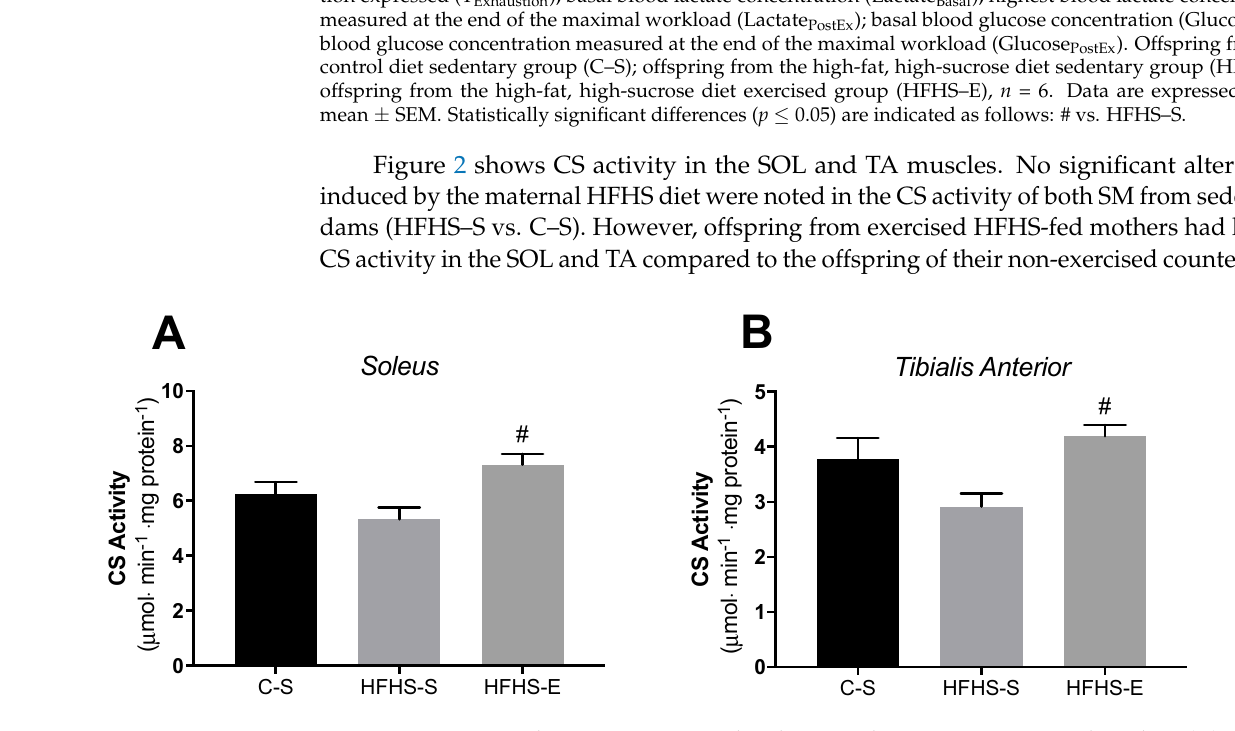
Figure 2. Citrate synthase activity normalized to muscle protein content in the soleus ( A ) and the tibialis anterior ( B ). Offspring from the control diet sedentary group (C–S); offspring from the high-fat, high-sucrose diet sedentary group (HFHS–S); offspring from the high-fat, high-sucrose diet exercised group (HFHS–E), n = 6. Data are expressed as the mean ± SEM. Statistically significant differences ( p ≤ 0.05) are indicated as follows: # vs. HFHS–S. The coefficient of variation in the soleus was: 6.8% for the C–S group; 4.5% for the HFHS–S group; and 4.3% in the HFHS–E group. In the tibialis anterior the coefficient of variation was: 5.7% for the C–S group; 7.1% for the HFHS–S group; and 2.7% in the HFHS–E group.